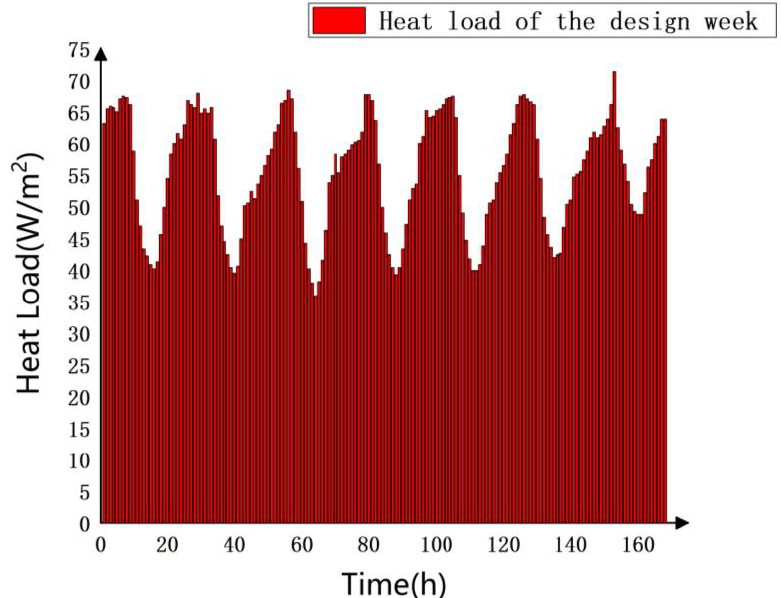
Figure 3. Heating load of the design week (7 consecutive days).